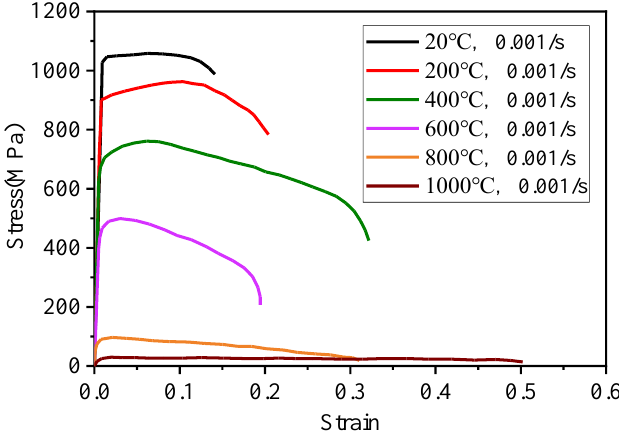
Figure 2. Stress – strain curve of Ti-6Al-4V with temperature [9] .